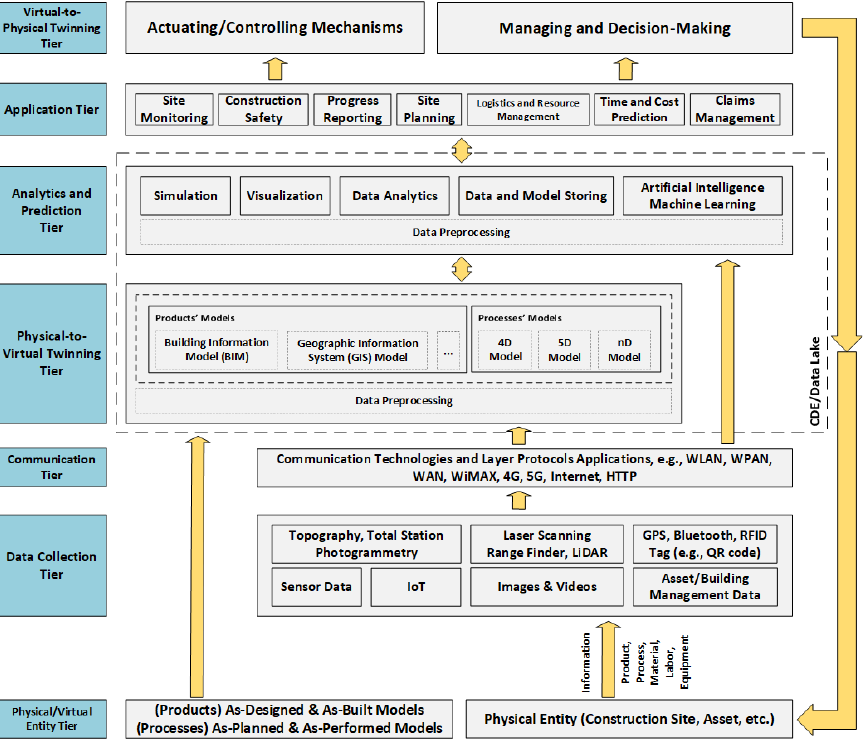
Figure 1. The Construction Digital Twin (CDT) framework for general contractors, including its tiers and enabling technologies examples.